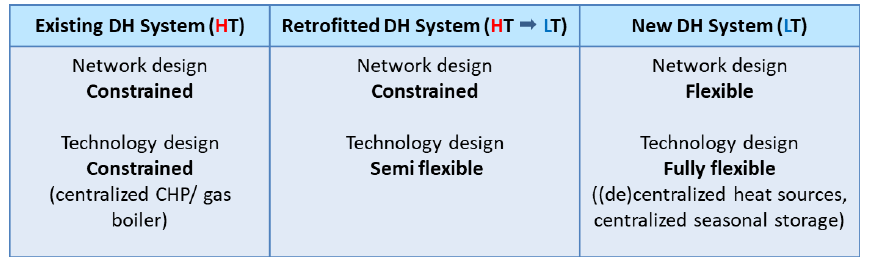
Figure 1. Implementation possibilities for LTDH